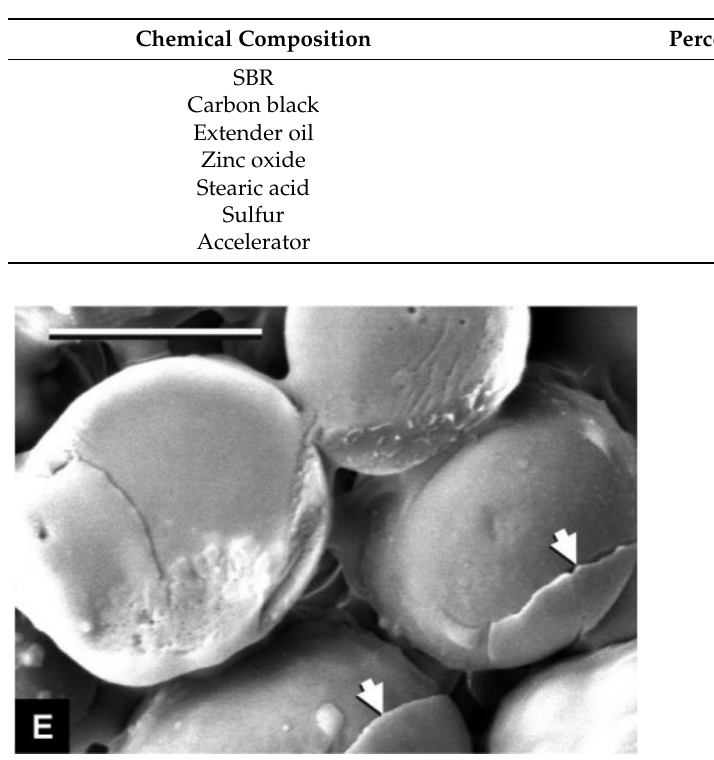
Figure 6. Rubber structure diagram: low-temperature field-emission SEM (at 4 kV) of frozen-hy- drated fractured particles; magnification bar = 2 mm [49]. fractured particles; magnification bar = 2 mm